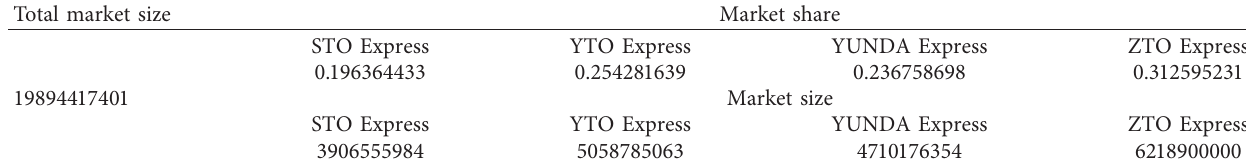
Figure 1: Example of Corollary 1. Table 2: Market size and market share data of listed express delivery companies.